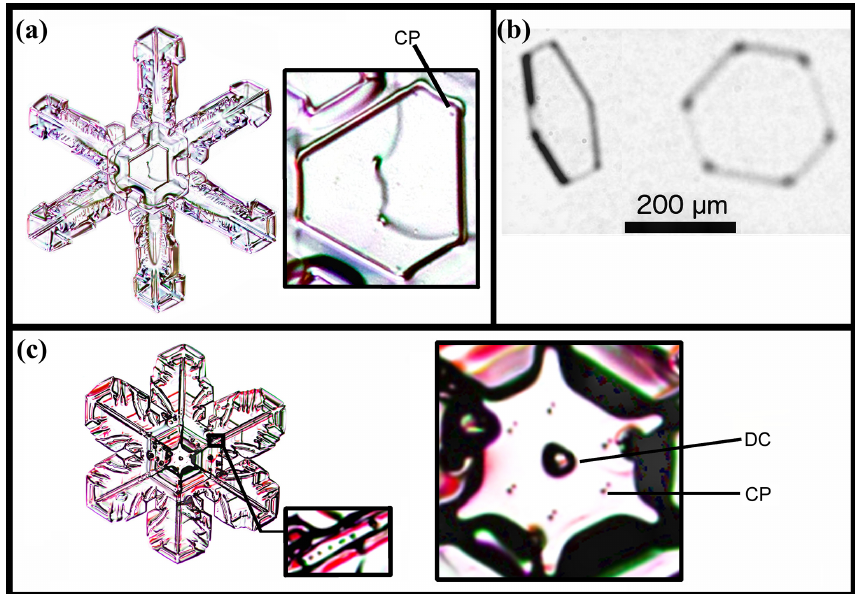
Figure 8. Corner pockets (CPs) and droxtal center (DC) on natural snow and ice crystals. (a) A narrow broad-branch crystal. (Curved line through crystal center is an imperfection on the glass slide.) (b) Crystal collected in-cloud at − 24 . 9 ◦ C, viewed at two angles. Image courtesy of Martin Schnaiter. (c) Case of a wide broad-branch crystal, with the large inset on the right showing a close-up of the center and the small inset showing pockets along one ridge (nearly identical to pockets along the other five main ridges). Snow-crystal images in (a) and (c) courtesy of Mark Cassino.